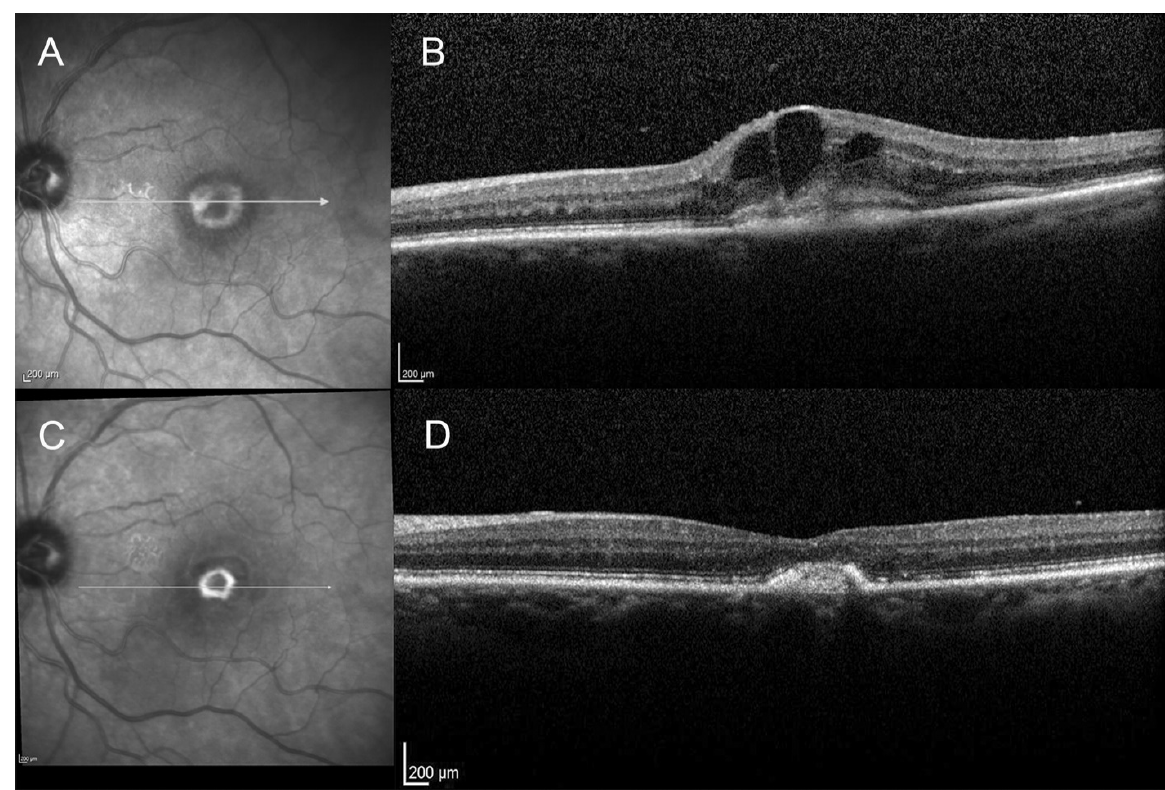
Figure 1. Spectral domain optical coherence tomography (SD-OCT) scans of a 79-year-old female patient with wet age- related macular degeneration (AMD), at baseline and at 3-month follow-up. ( A ): Infrared reflectance photography at baseline showing a hyperreflective foveal ring. ( B ): SD-OCT scan at baseline, showing a pre-epithelial neovascular lesion (type 2 lesion) with subretinal hyperreflective exudation and intra retinal cysts. ( C ): Infrared reflectance photography at 3-month follow-up, showing the strengthened and well demarcated hyperreflective ring. ( D ): SD-OCT scan at 3-month follow-up showing a hyperreflective subretinal lesion, forming the fibrovascular pigment epithelial detachment (PED).